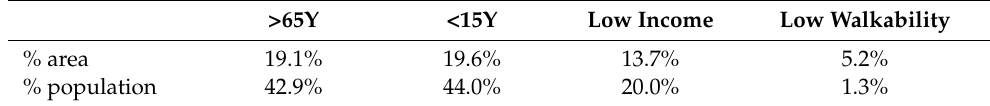
Table 3. The percentage of the residential area and percentage of the population in residential areas that lives in areas with a lot of older people, a lot of younger people, low incomes or low walkability. The percentages are based on the mFREI scores that are calculated with the Locatus data and the extra dataset of community gardens, farmers’ markets and farmers’